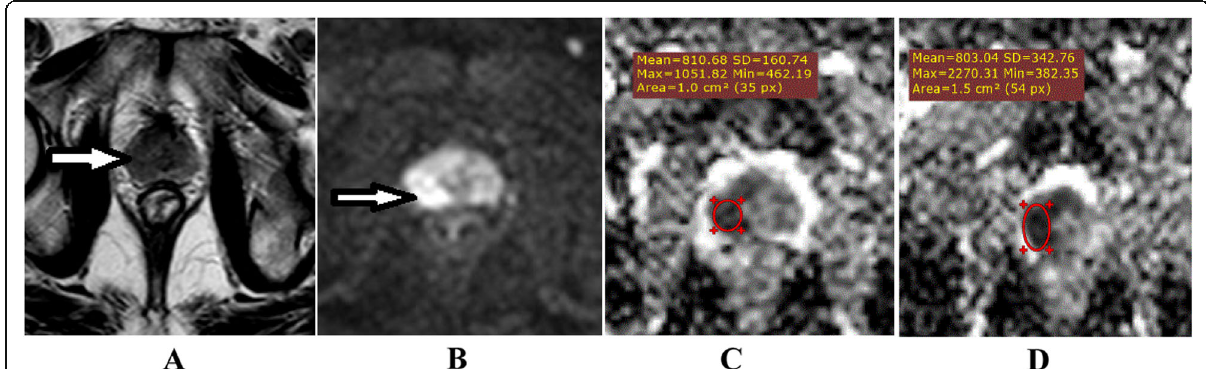
Fig. 2 A 70-year-old man with total PSA 35 with discordant interpretation in terms of PIRADSv2 DWI score. a Axial T2 showing bilateral diffuse (non-circumscribed) low signal intensity of the peripheral zone near the apex. b DWI (800) showing bilateral focal bright signal intensity lesions in PZ (not markedly hyperintense). c , d ADC map also shows low signal intensity of the lesions with mean ADC value 0.782. The ADC ratio between benign prostatic tissues was 1.63. The qualitative DWI score was 4 for reader 1 and 3 for reader 2 histopathology was adenocarcinoma GS 4 + 3 = 7)